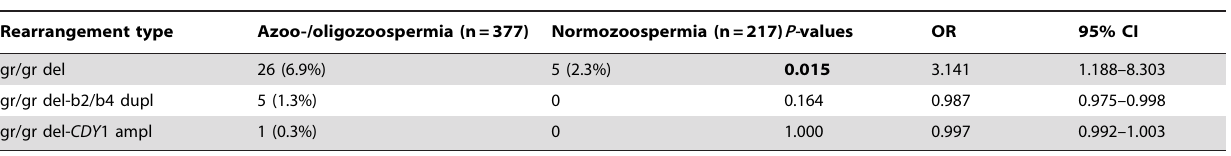
Table 3. The frequency of gr/gr rearrangements according to analyses of DAZ - CDY 1 gene copy number.